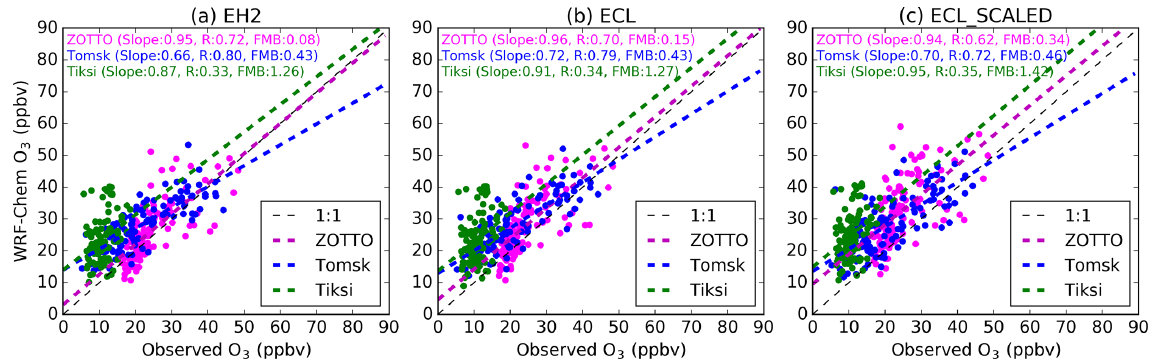
Figure 6. Daily mean surface ozone comparisons for three ground observation sites within the study domain: ZOTTO (magenta), Tomsk (blue) and Tiksi (green) for 1 May–31 August 2011. Panel (a) shows WRF-Chem surface ozone using EH2 anthropogenic emissions, panel (b) shows WRF-Chem surface ozone using ECL anthropogenic emissions and panel (c) shows WRF-Chem surface ozone using ECL_SCALED anthropogenic